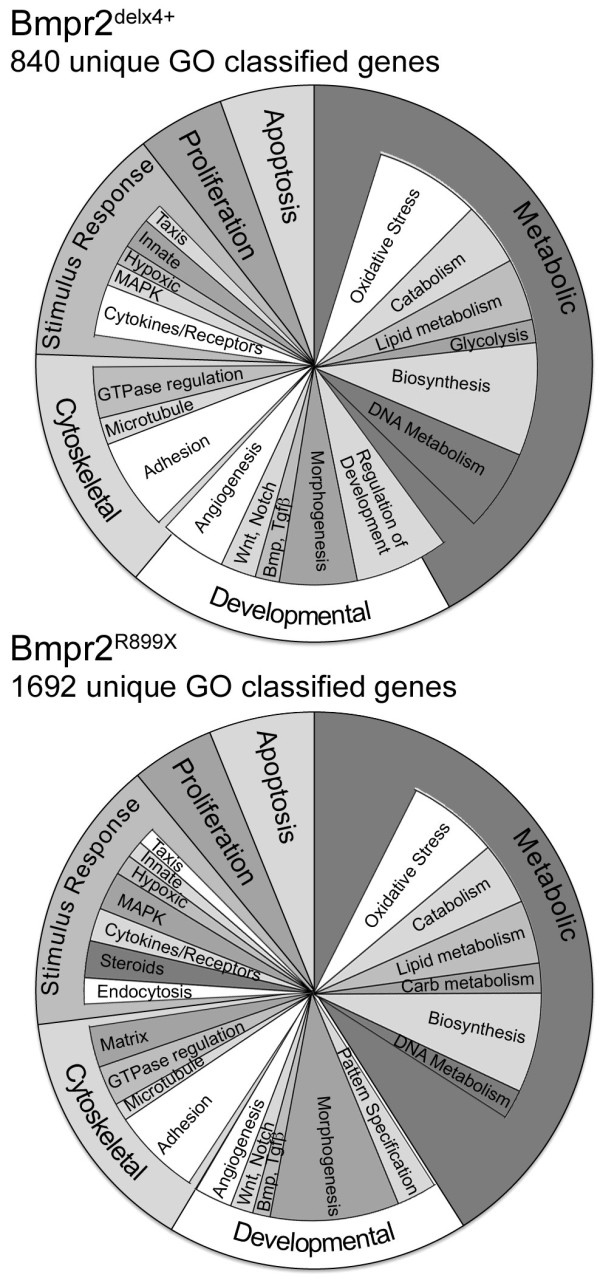
Gene ontology classification of genes dysregulated in PMVEC cultured from BMPR2delx4+ mice (top) or Bmpr2R899X mice (bottom) indicates very similar patterns of gene dysregulation between mutation types. Angular width of sections corresponds to proportion of genes within that ontology group. Outer labels correspond to top-level gene ontology groups: inner circle corresponds to more detailed gene ontology classification, all from the biological process tree. Most genes fall into more than one lower-level category, and so lower-level categories selected are meant to be representative, but are somewhat arbitrary. Full GO listing is included in Supplemental Tables 1 and 2.